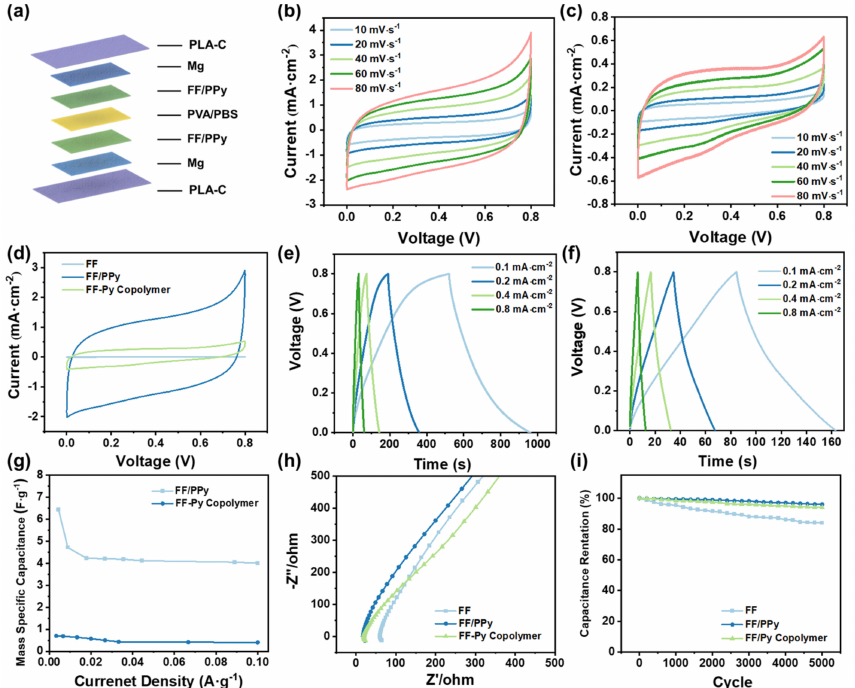
Figure 3. Electrochemical performance of all-solid SCs based on FF films, FF/PPy film with 150 cycles of PPy deposition, and FF–Py copolymer films with a ratio of 1:1. ( a ) Structure schematic of the FF/PPy-based SCs; ( b – d ) CV curves of FF/PPy-based SCs ( b ) and the SCs using FF–Py copolymer film ( c ) at different scan rates, respectively; ( d ) comparison of SCs based on FF, FF/PPy, and FF–Py copolymer films; ( e ) GCD curves of FF/PPy-based SCs at different current densities; ( f ) GCD curves of the SCs using FF–Py copolymer film at different current densities; ( g ) mass specific capacitances variation of SCs based on FF/PPy and FF–Py copolymer films with different scan rates; ( h ) Nyquist plot reflecting the impedance characteristics of SCs; ( i ) cycle stability test with the current density of 0.2 mA · cm − 2 at 0.8